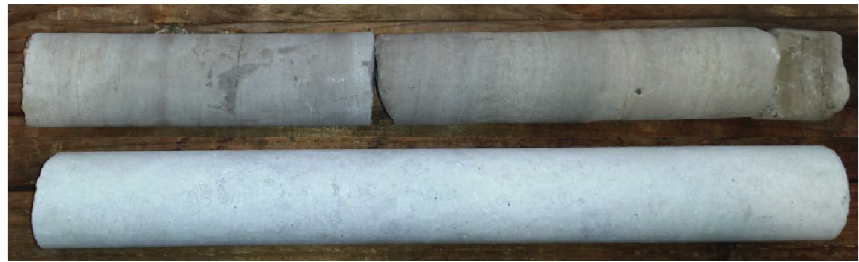
Figure 11: Recovered core (bottom: marble; Top: